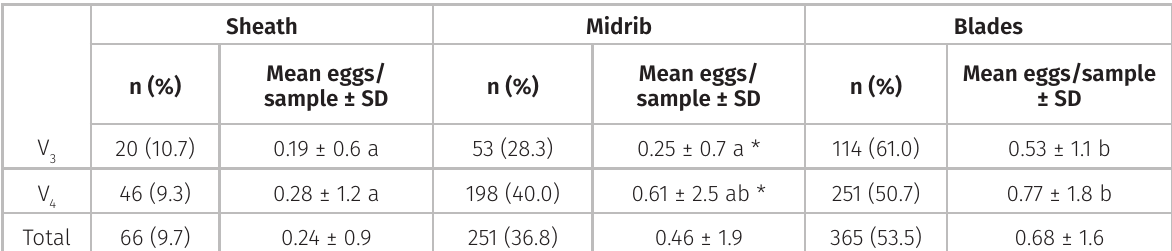
Table I. Location of Dalbulus maidis eggs in different parts of the maize leaves, data of total numbers (n), percentage (%) mean and standard deviation (SD) are presented. V leaves, respectively. Significant differences between plant classes within each leaf sector location are indicated by an asterisk; significant differences between leaf sectors within each plant class location are indicated by a different letter (Tukey HSD test; p < 0.05). Note that percentages indicated within brackets are added within each plant class or total and therefore they must be read by